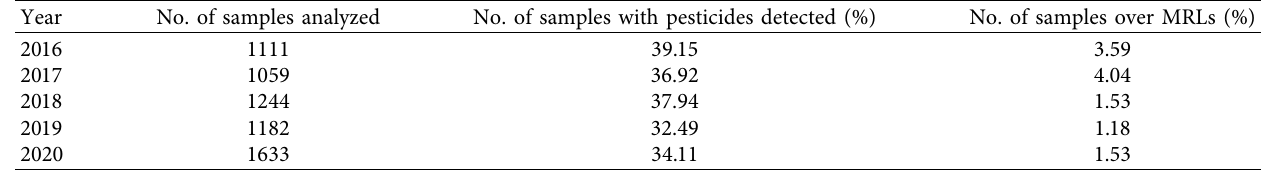
Table 2: The variations of pesticide residue levels in brown rice samples in different years in China.